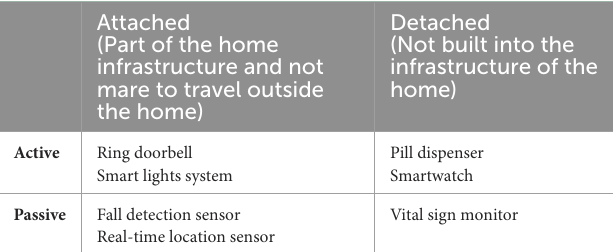
TABLE 1 St(aging)-in-place ICT